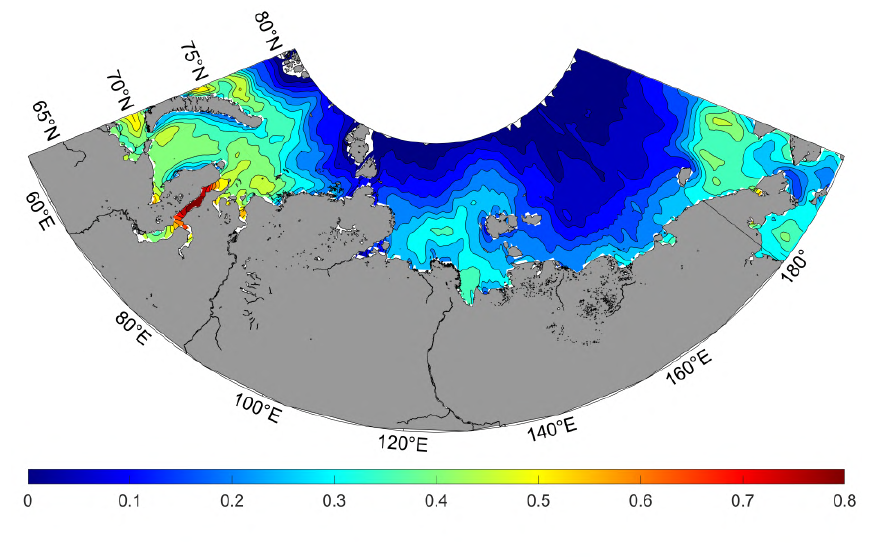
Figure 5. Climate trend based on SST data [39] analysis ( ◦ C/decade). After eliminating the linear trend, the new T (cid:48) ( t k ) series was used to estimate MHWs in the same way as the original T ( t k ) series in accordance with Equations (1)–(3). Figure 6 represents the resulting index